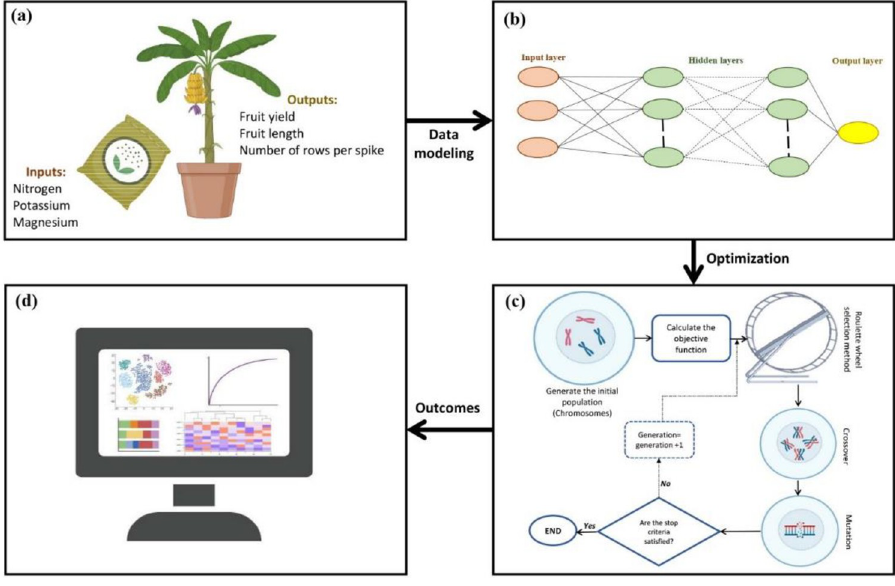
Fig 1. The schematic view of the step-by-step procedure of the present study (a) data collection, (b) modeling the FY, FL, and NRPS based on three input variables including N, K, and Mg using ANNs, (c) optimization process via genetic algorithm and (d)